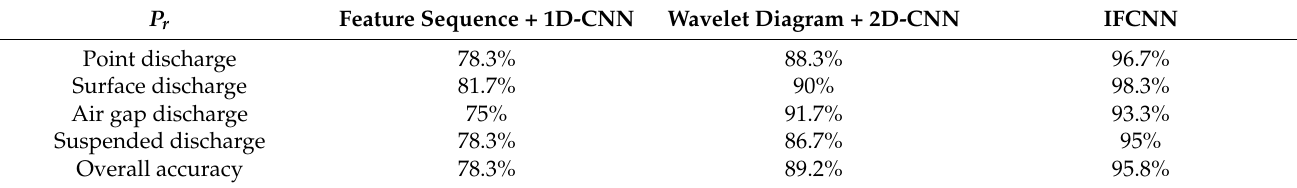
Table 5. PD recognition results from different